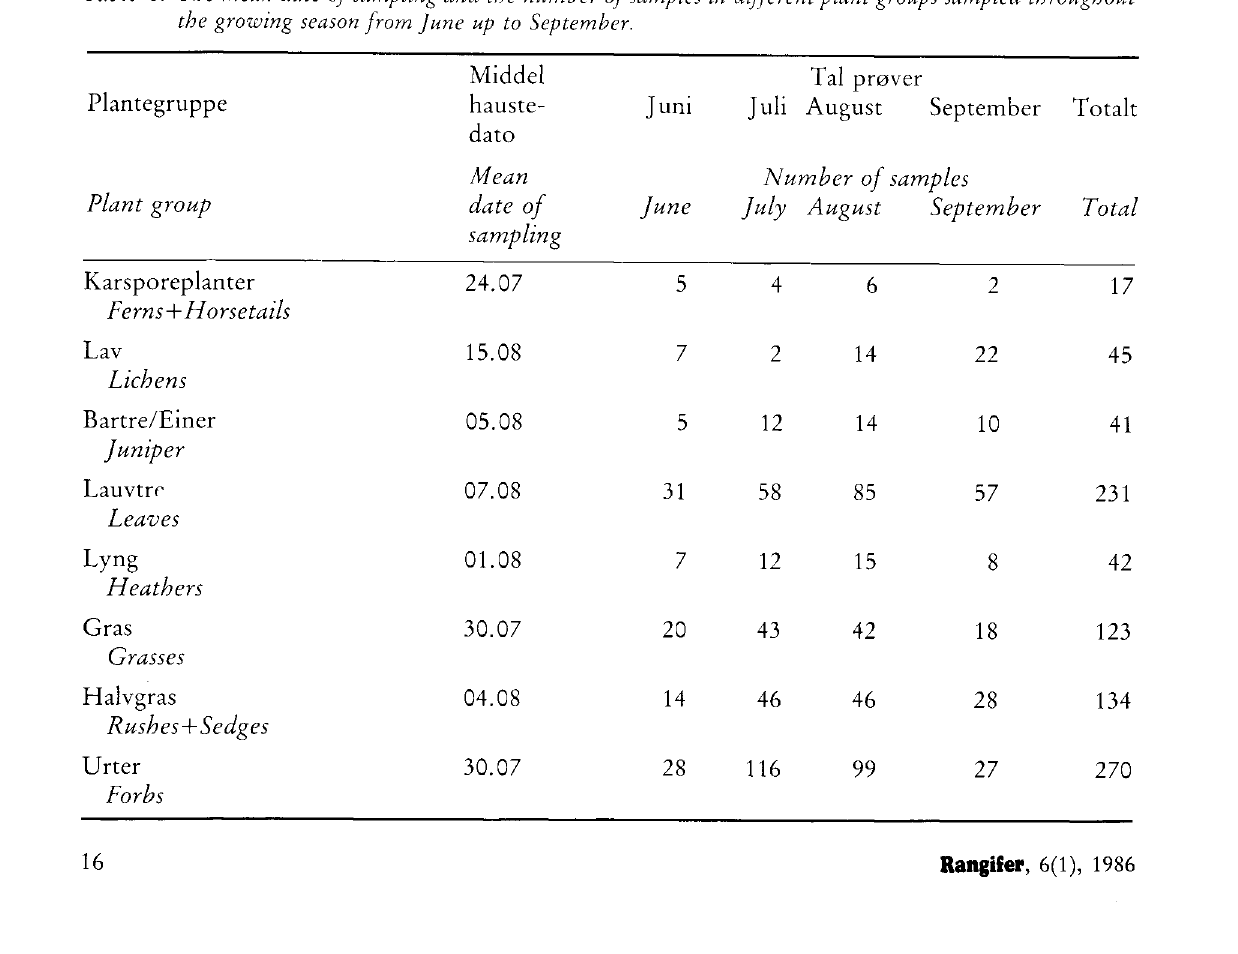
Table 1. The mean date of sampling and the number of samples in different plant groups sampled throughout the growing season from June up to September.